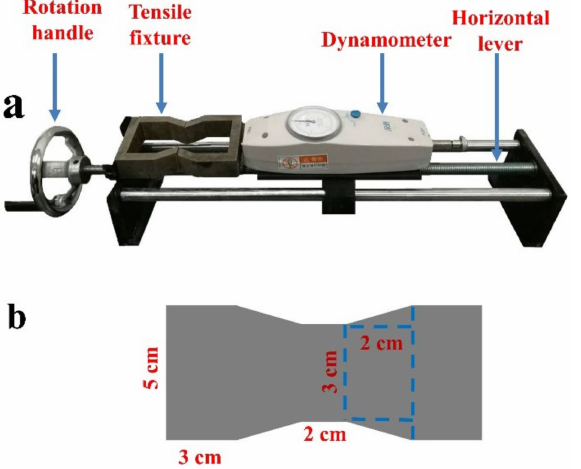
Figure 4. Device ( a ) and sample dimension ( b ) for tensile